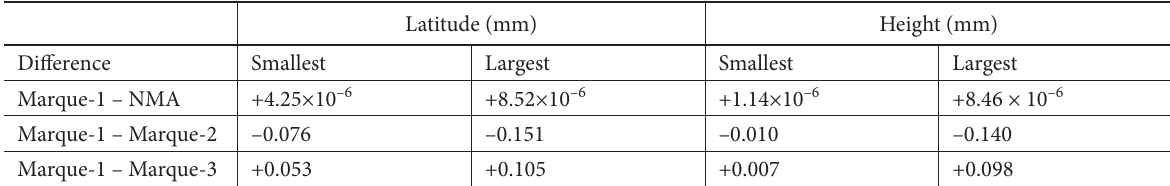
Table 3. The smallest and largest differences in latitude and